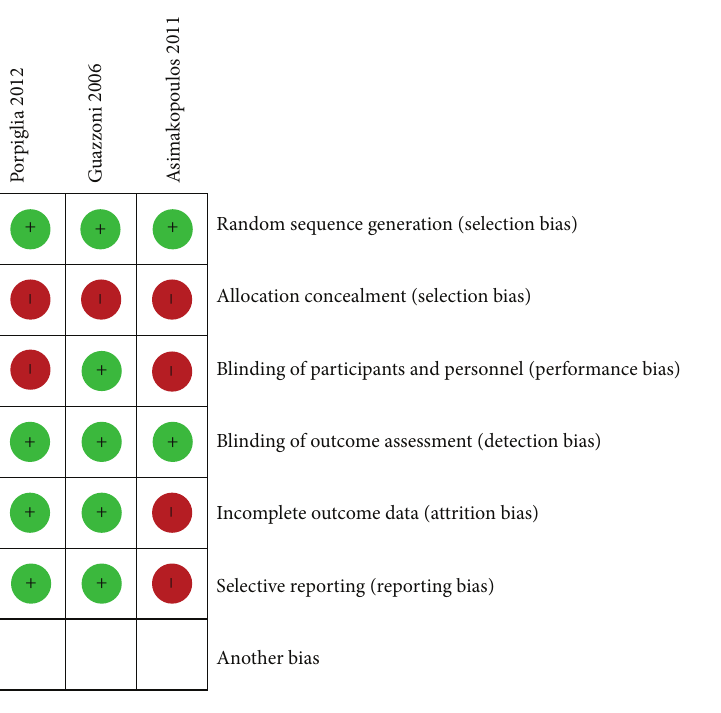
Figure 1: Risk of bias assessment of trials included in the